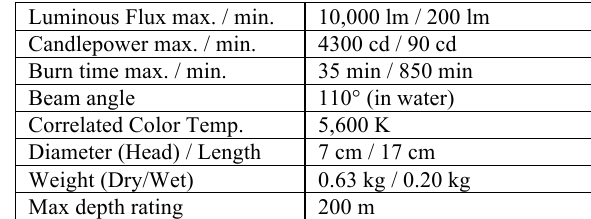
Table 3 . Technical specs of the Keldan Video 4X 10000 lm CRI 85 light used for the compact underwater cave